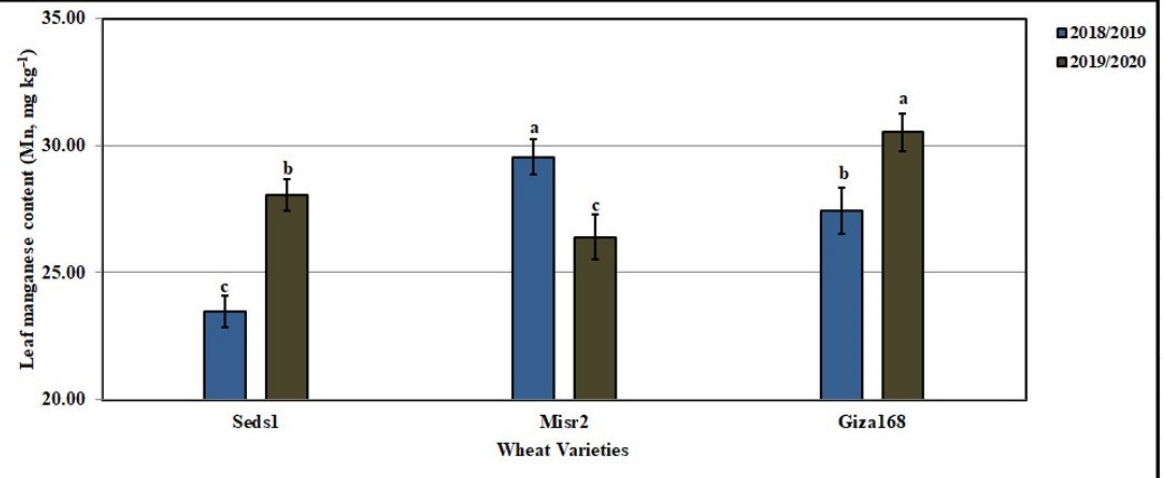
Figure 29. Influence of wheat varieties on leaf iron contents (Fe, mg kg − 1 ) in clay loam soil in 2018/2019 and 2019/2020 seasons. Bars in the same years with a different letter indicate significant differences between treatments at p ≤ 0.01. HS 1, HS 2 , HS 3 represent HS applied as foliar spray at 1.0, 2.0, 4.0 g L − 1 , respectively, HS 4 , HS 5 , HS 6 represent HS applied as soil application at 5.04, 7.56, 10.08 kg ha − 1 .